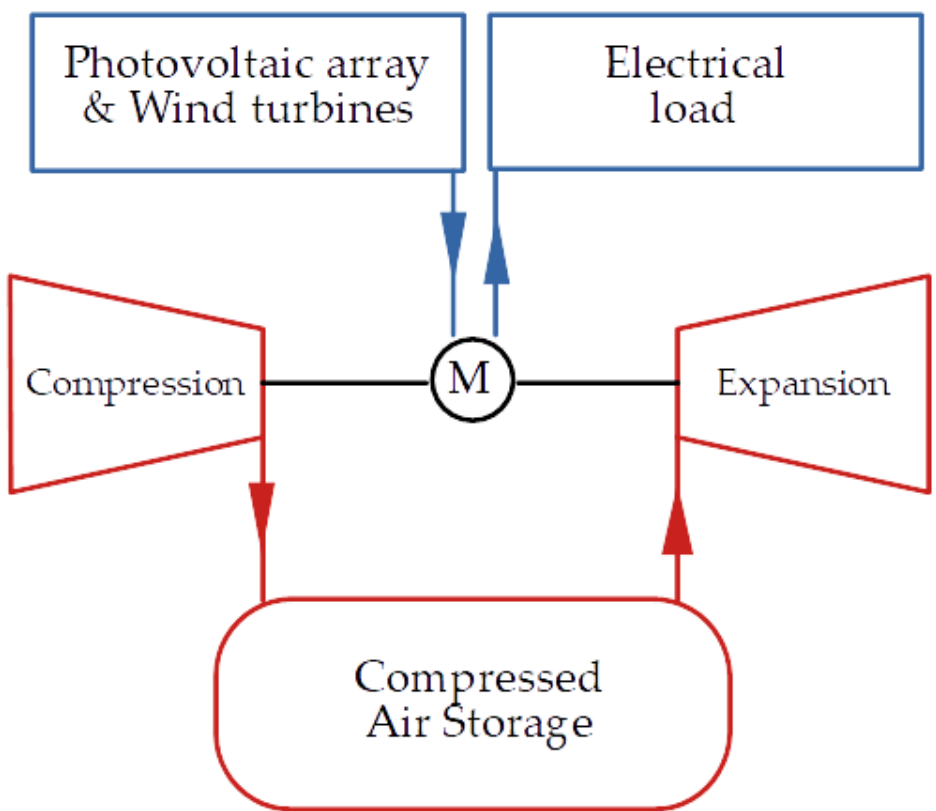
Figure 1. Schematic of modeled system. Power lines are colored blue, while the air compression and expansion cycle are colored red.